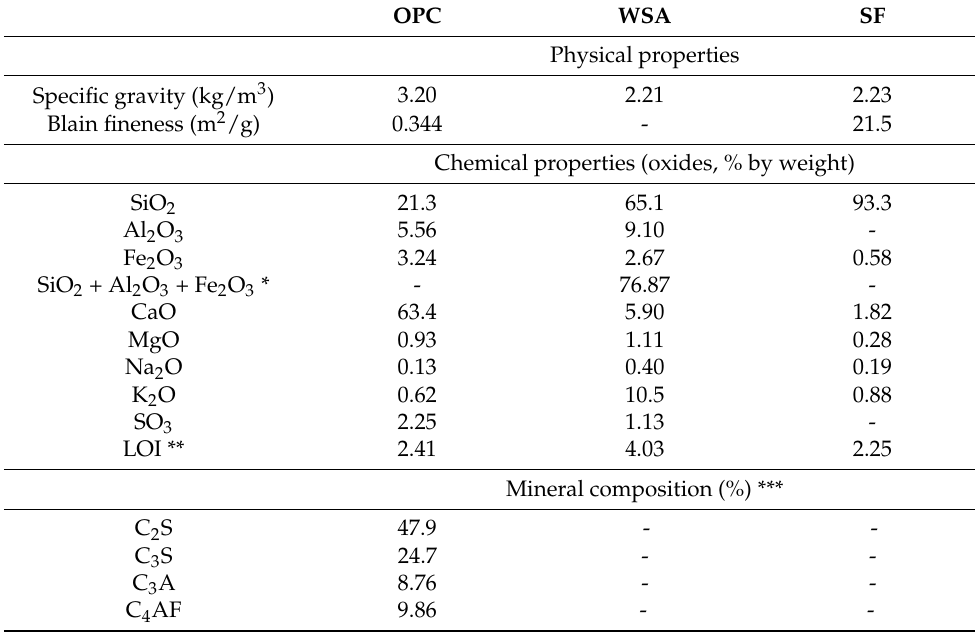
Table 1. Physical and chemical properties of cement, WSA, and